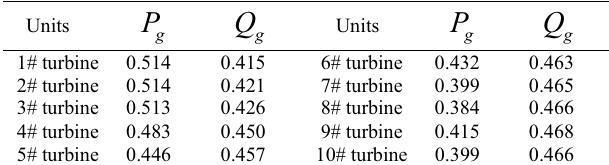
Table 3. Active power and reactive